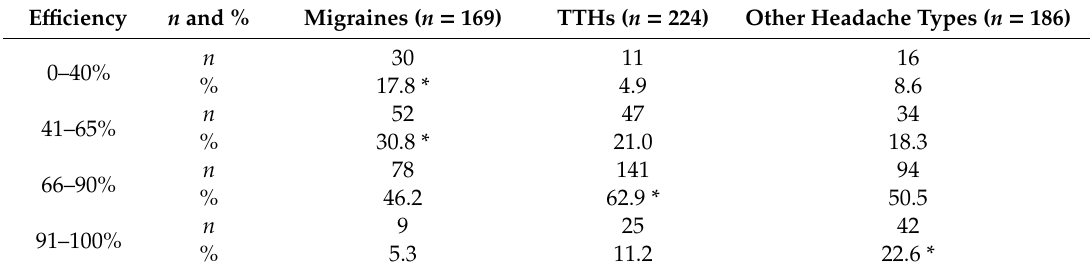
Table 4. Self-reported e ffi ciency of subjects, number ( n ) and percentage (%), while working with headaches from the studied headache